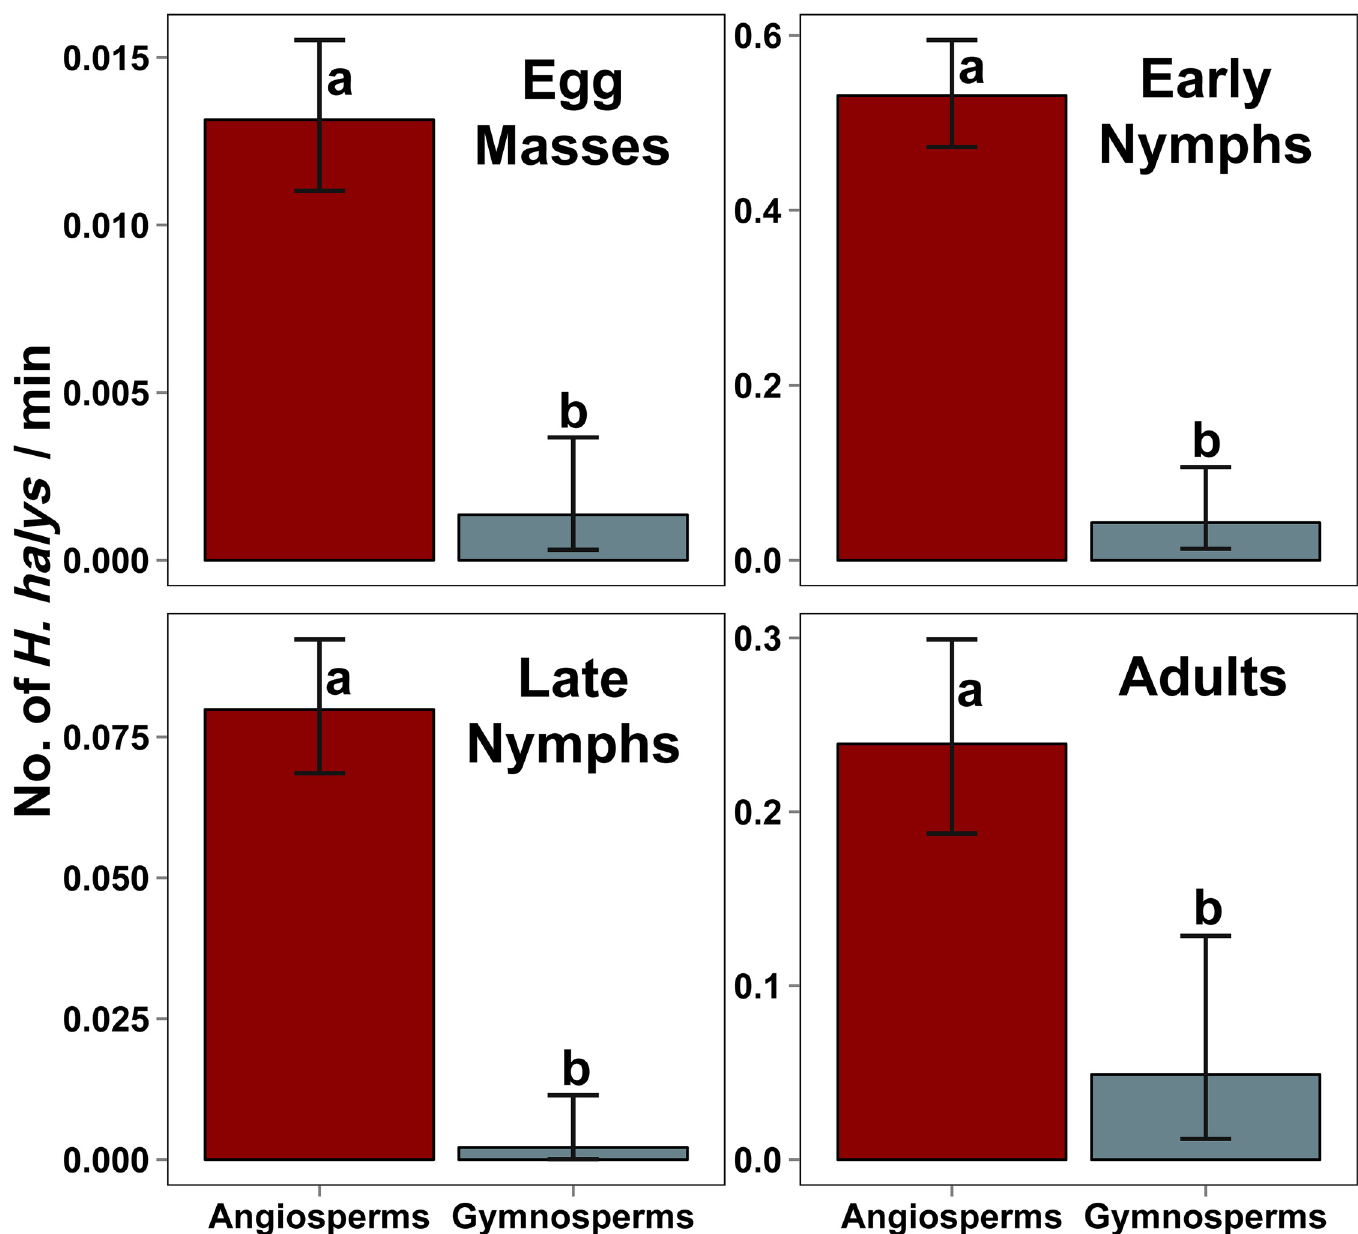
Fig 1. Relationship between Halyomorpha halys abundance and plant taxonomic status across stink bug life stages. Model estimated mean abundances (and 95% CI) are plotted for egg masses, early instar nymphs, late instar nymphs and adults. For each life stage, angiosperms supported significantly more stink bugs than gymnosperms based on Tukey ’ s HSD comparisons ( α = 0.05) indicated by different letters above the